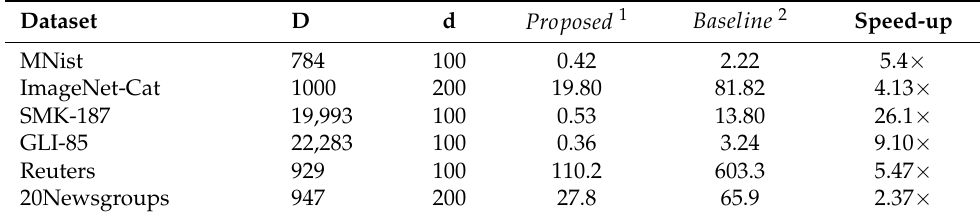
Table 3. Training time reduced with our method compared to that of vanilla kernel k-means. In general, the higher the original dimensionality (D), the more the speed-up.